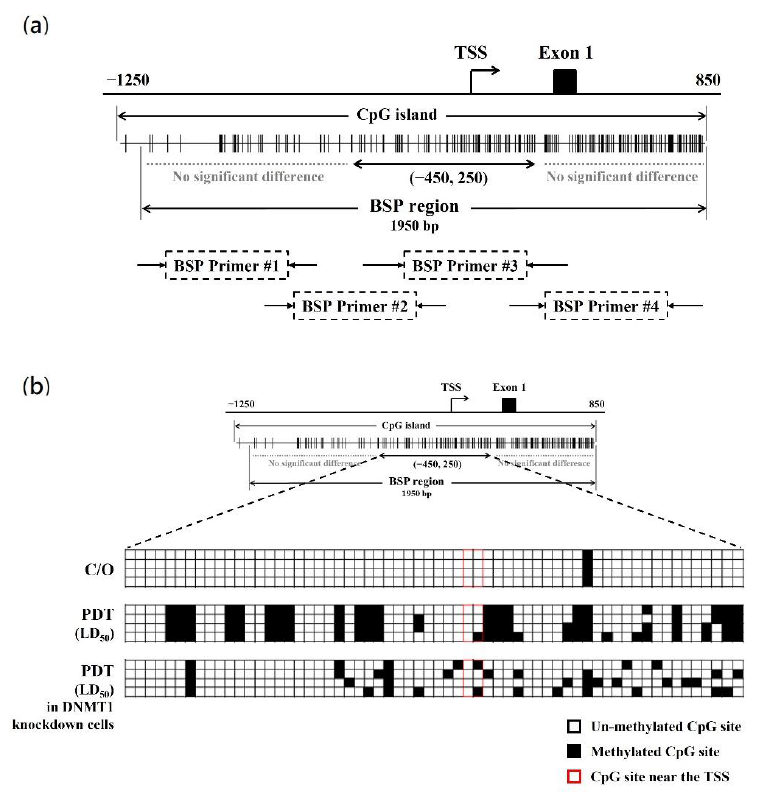
Figure 6. PDT induces the methylation alteration of CLIC4 promoter region in a DNMT1-dependent manner. ( a ) Schematic diagram of the CpG island of CLIC4 promoter. The distribution of CpGs crosses over the promoter and the first exon of CLIC4 gene. The transcriptional start site (TSS) is indicated. Each vertical bar represents the presence of a CpG dinucleotide. BSP1, BSP2, BSP3 and BSP4 represent the regions selected for bisulfite sequencing PCR (marked as BSP region); ( b ) Direct sequencing of bisulfite PCR products was performed in melanoma A375 cells: no-treatment control group, PDT-treated cells, and PDT-treated DNMT1-knockdown cells. Genomic DNA was extracted from cells 24 h after ALA-PDT with the light dose of 2 J/cm 2 . Quantification of the bisulfite-sequencing data, shown as the percentage of DNA methylation ( n = 4) of the region among the CLIC4 gene from position nt. − 450 to +250. Methylation status of cytosine is shown as follows: filled square ( ◼ ), methylated; open square ( ◻ ), unmethylated.